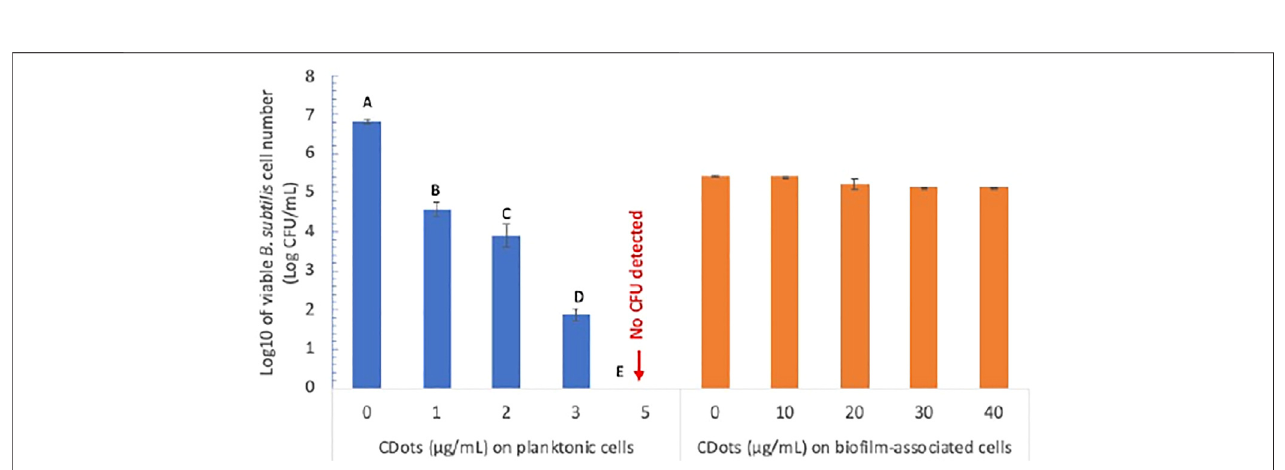
FIGURE4| TheantimicrobialeffectsofEDA-CDotson B.subtilis cellsinplanktonicandbio fi lm-associated originswith1 hvisiblelighttreatment.Dataispresented as the mean values with ± standard deviation as error bars. Statistical analysis was performed within the data of planktonic cells and within bio fi lm-associated cells, respectively. Different letters above the columns indicate statistically signi fi cant differences with p < 0.05; no statistical difference within the data of bio fi lm- associated